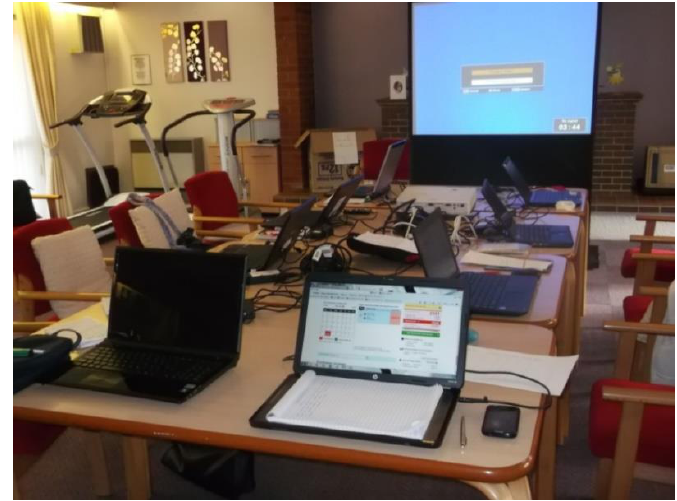
Figure 18. Example of a computing classes promoting respect and social inclusion (P21) (St. Luke’s court, Liverpool).